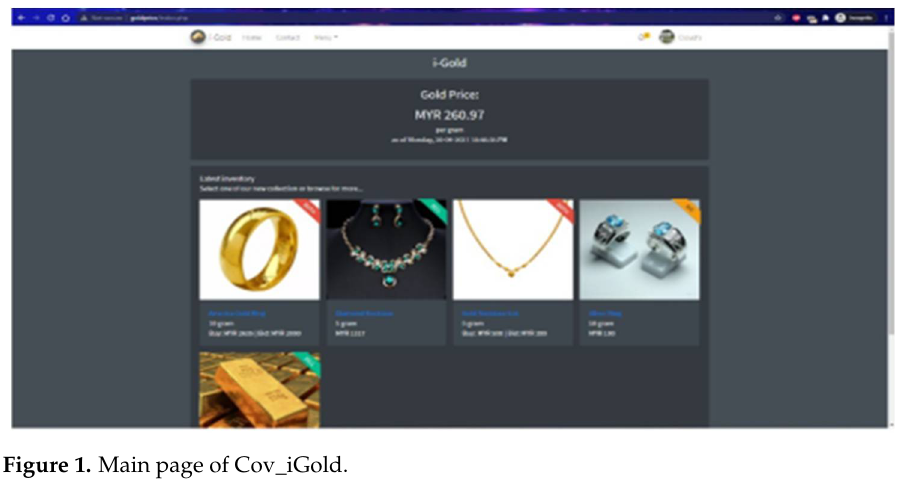
Figure 1. Main page of Cov_iGold.